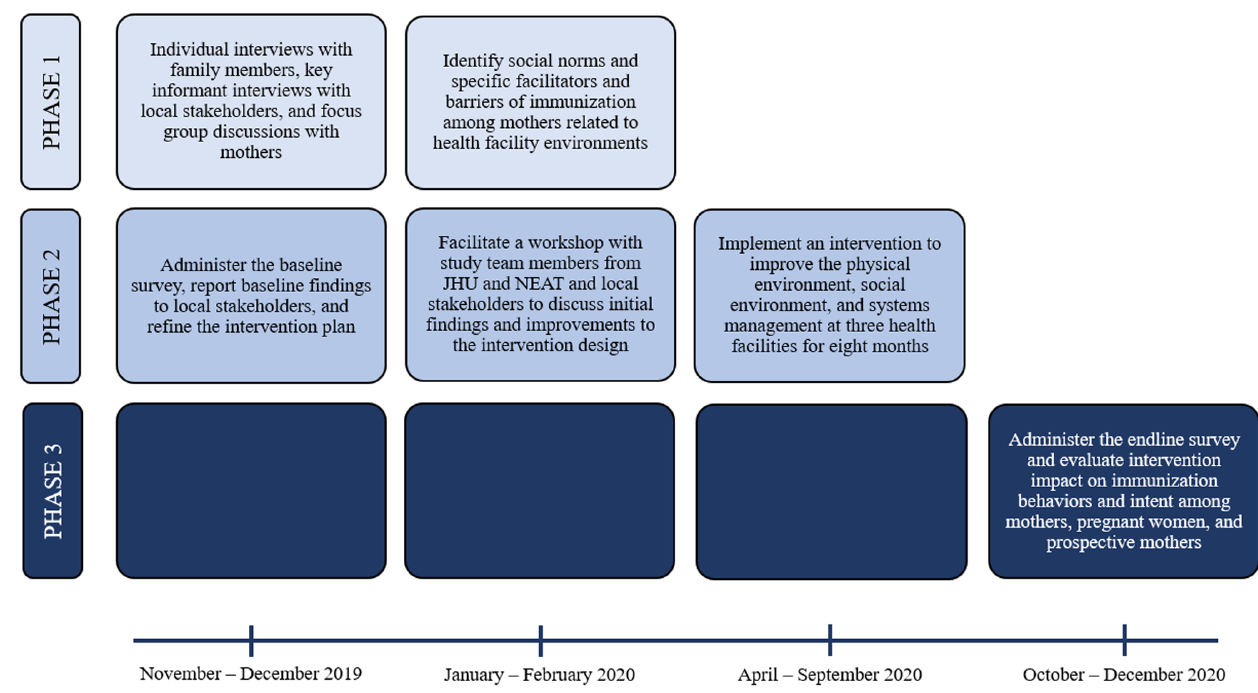
Figure 2. Research study workflow and